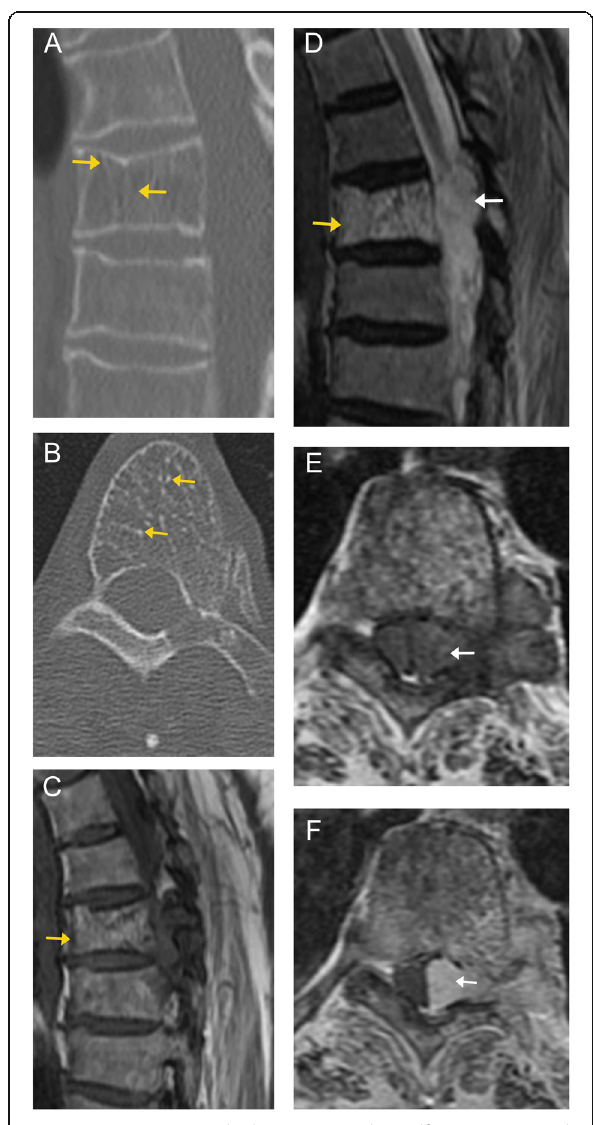
Fig. 2 Compressive vertebral venous vascular malformation. Sagittal ( a ) and axial ( b ) CT images in the bone window of the thoracic spine demonstrate decreased attenuation of the T4 vertebral body, as well as the left pedicle and transverse process. A characteristic “ polka-dot ” sign is seen in the vertebral body on the axial image, with high attenuation dots representing replacement of normal cancellous bone by thick, vertical trabeculae (orange arrows) surrounded by vascular lacunes and fatty marrow. Sagittal MR images demonstrate a heterogenous, predominantly high signal lesion on both T1 ( c ) and T2 ( d ) weighted sequences involving the T4 vertebral body (orange arrows), with lobular extension into the spinal canal (white arrows). Axial T1 pre- ( e ) and post-contrast ( f ) images demonstrate avid enhancement of the lesion. Again, there is extension of the lesion from the vertebral body into the spinal canal, with resulting compression of the spinal